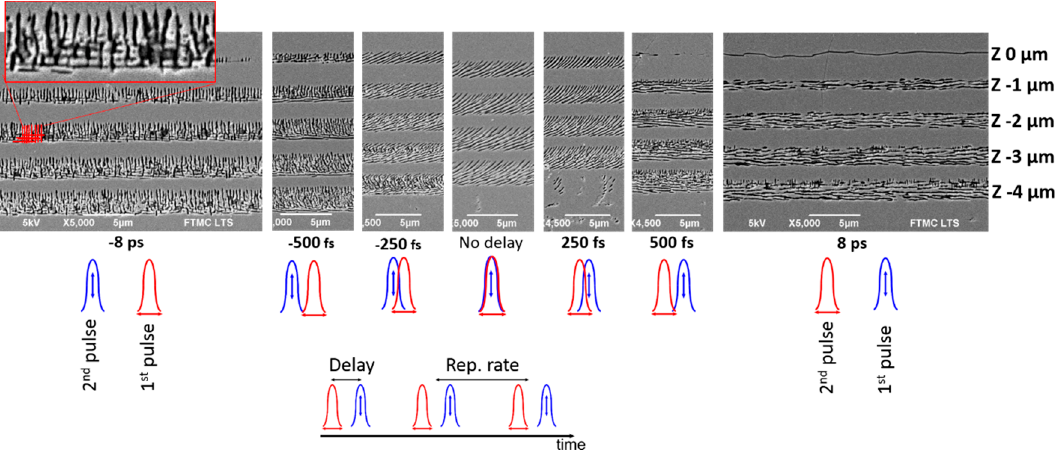
Figure 5. SEM pictures of the nanograting morphology evolution depending on the delay between two pulses. The inset shows the enlarged area of the grid-like nanograting structure. The nanostructures recorded with a total 400 nJ pulse energy (200 nJ + 200 nJ).